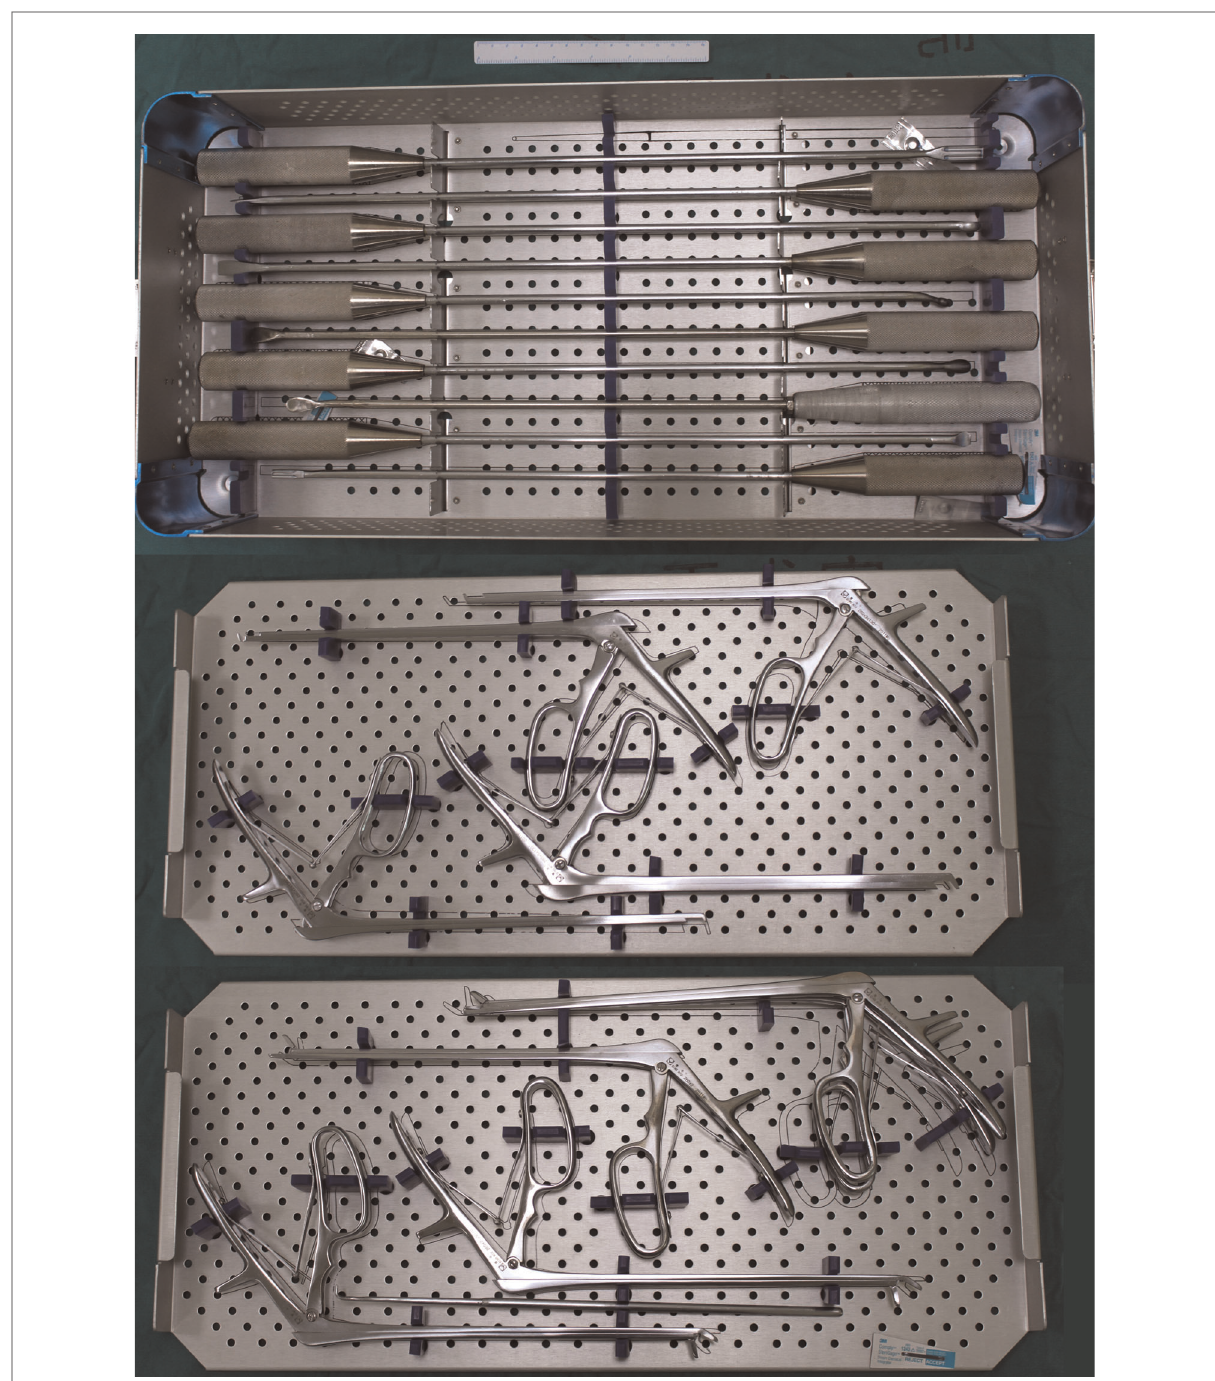
FIGURE 3 Operative instruments for robot-assisted laparoscopic retroperitoneal debridement surgery. Scale bar=15